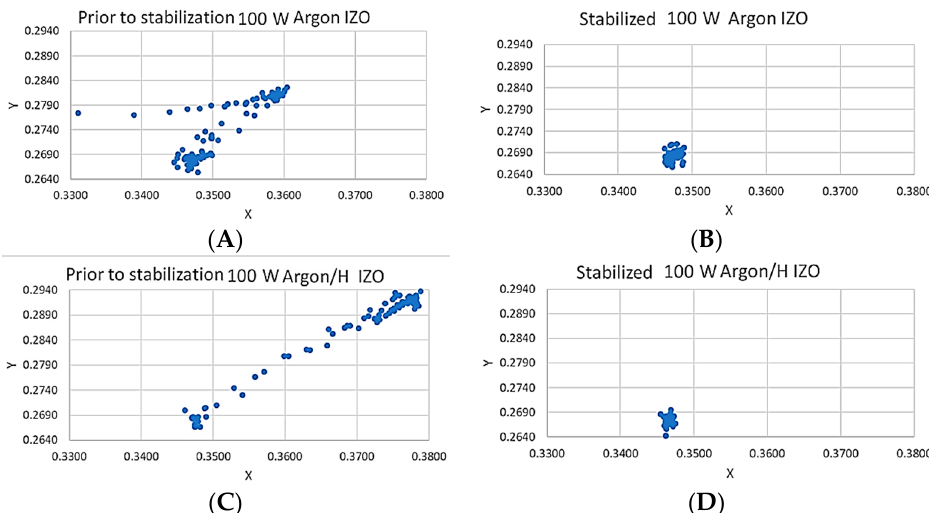
Figure 4. The x and y data obtained from the plasma during the first hour of ignition at 100 W for a magnetron fitted with Indium Zinc Oxide (IZO) target under gas Ar ( A , B ) and gas ArH ( C , D ) along with data obtained 2 h after ignition. During this 1 h interval the plots remain relatively stable as presented in the right side figures. The stabilized data were gathered over an additional thirty minutes period. As it can be seen ( A , C ) prior to stabilisation the x,y coordinates are scattered across the plot area until the plasma is stabilized at which point the plots fall within close proximity ( B , D ).